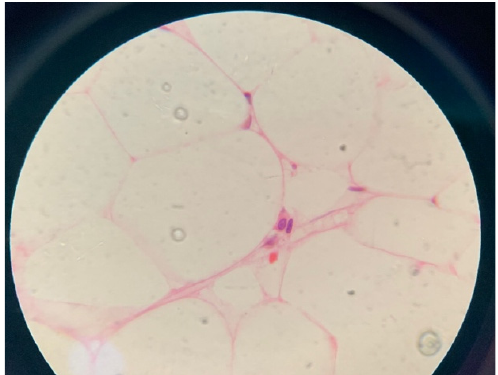
Figure 1. Microscopic picture of bone marrow tissue showing hypocellularity (average cellularity is 25%).